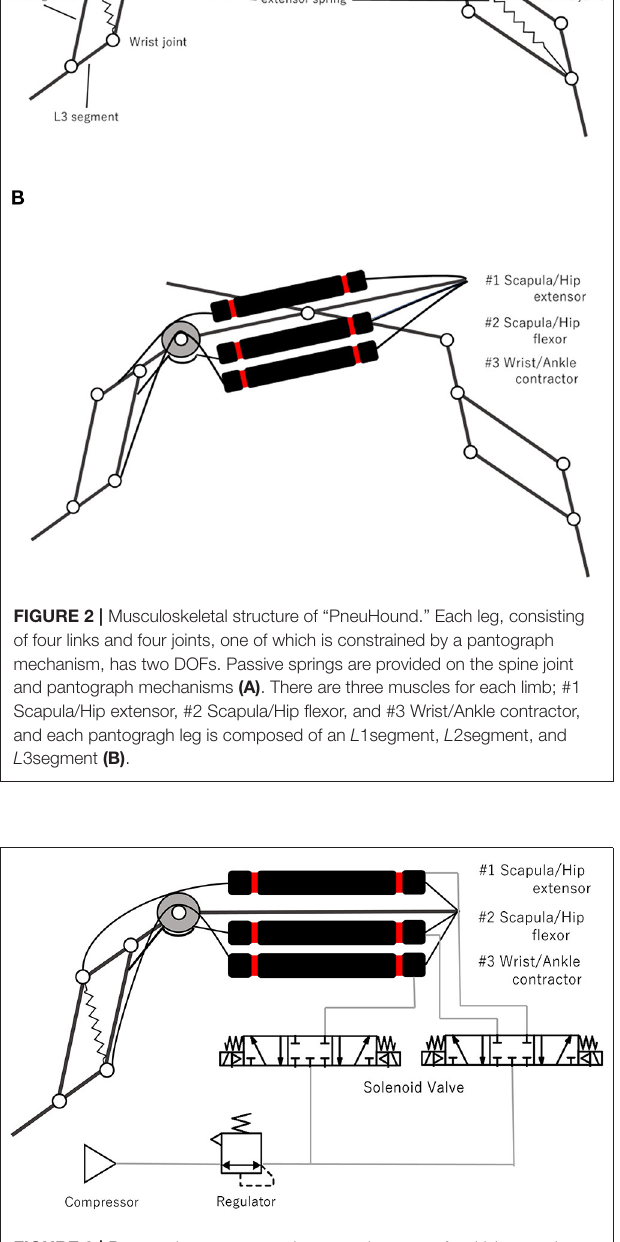
is very small (5 mm); this ensures that the flexors can shorten the leg while minimizing the influence of the muscle driving the scapula and hip joints.